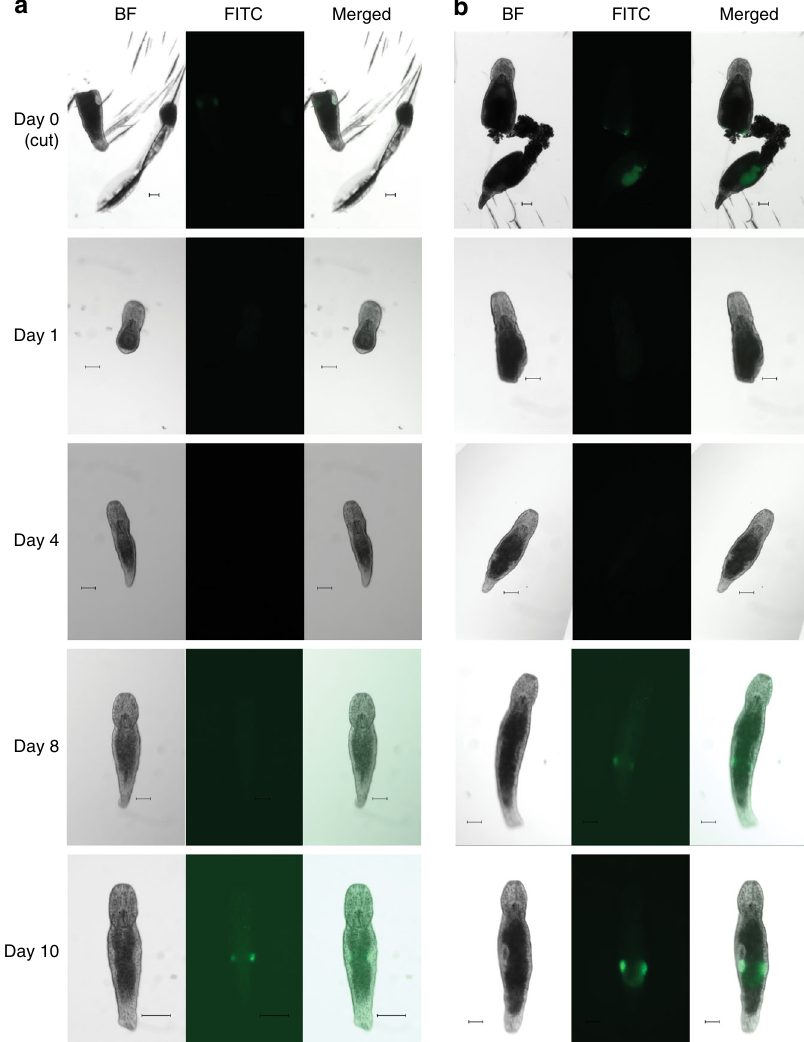
Fig. 4 Transgene expression during regeneration. a Testes-speci fi c transgenic line NL23. b Ovaries-speci fi c transgenic line NL22. BF — bright- fi eld, FITC — FITC channel. Day 0 — animals immediately after amputation, both head and tail regions are shown. Only regenerating head regions are subsequently followed. Scale bars are 100 μ